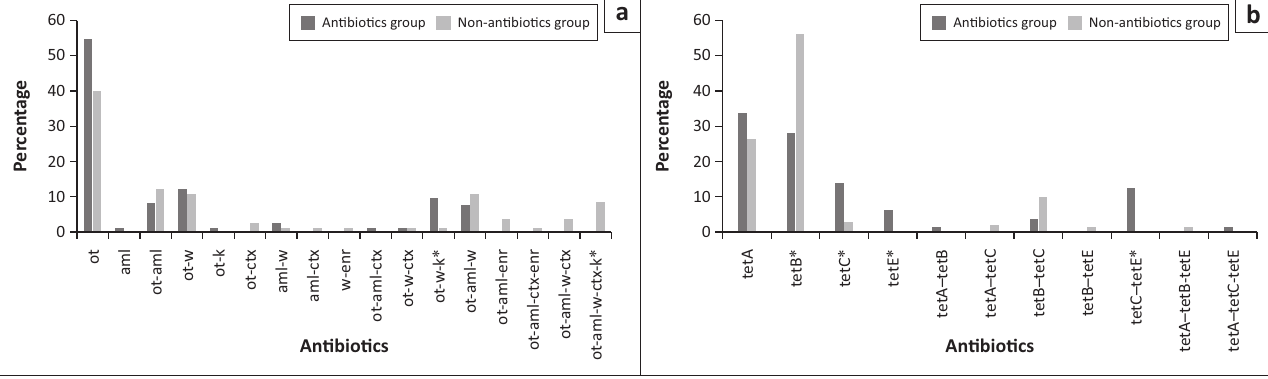
FIGURE 4: Frequency of (a) phenotypic combination of resistance among the seven antimicrobials tested and (b) genotypic combination of tet genes observed within each of the resistant Escherichia coli isolates for both groups